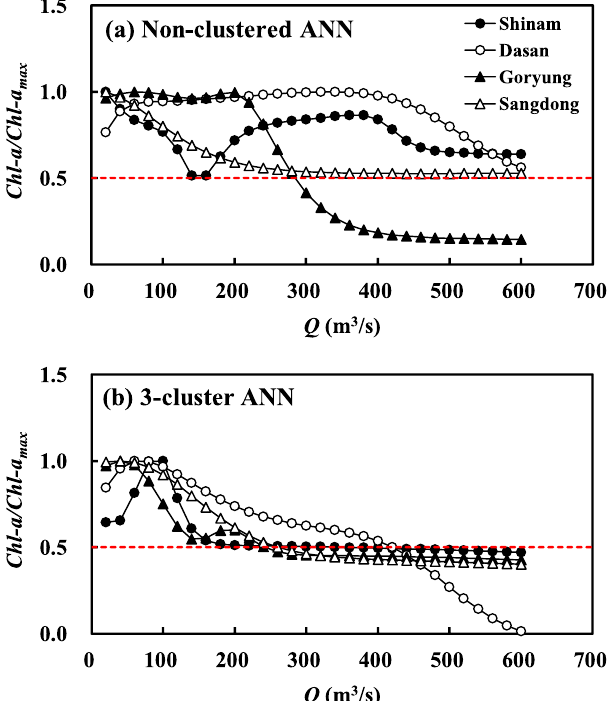
Figure 5. Response of Chl-a to increase in Q , estimated by non-clustered ANN models and 3-cluster ANN